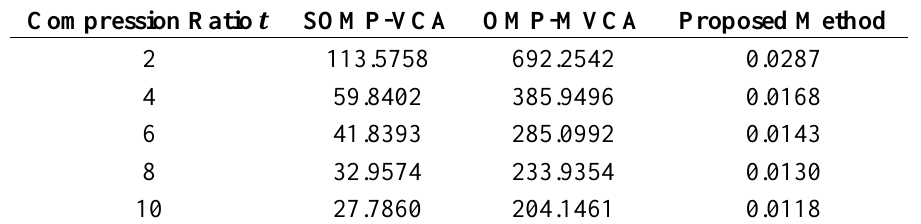
Table 7. Urban HSI: average runtime consumed by the two methods for estimating the endmembers. Compression Ratio